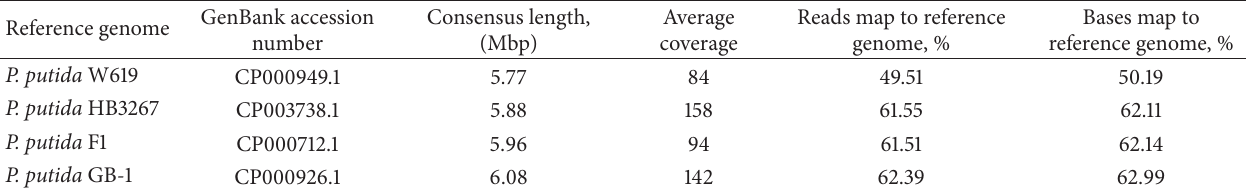
Table 1: Summary of reference genome mapping of P . putida T2-2 against the complete genome of P . putida W619, P . putida HB3267, P . putida F1, and P . putida GB-1.